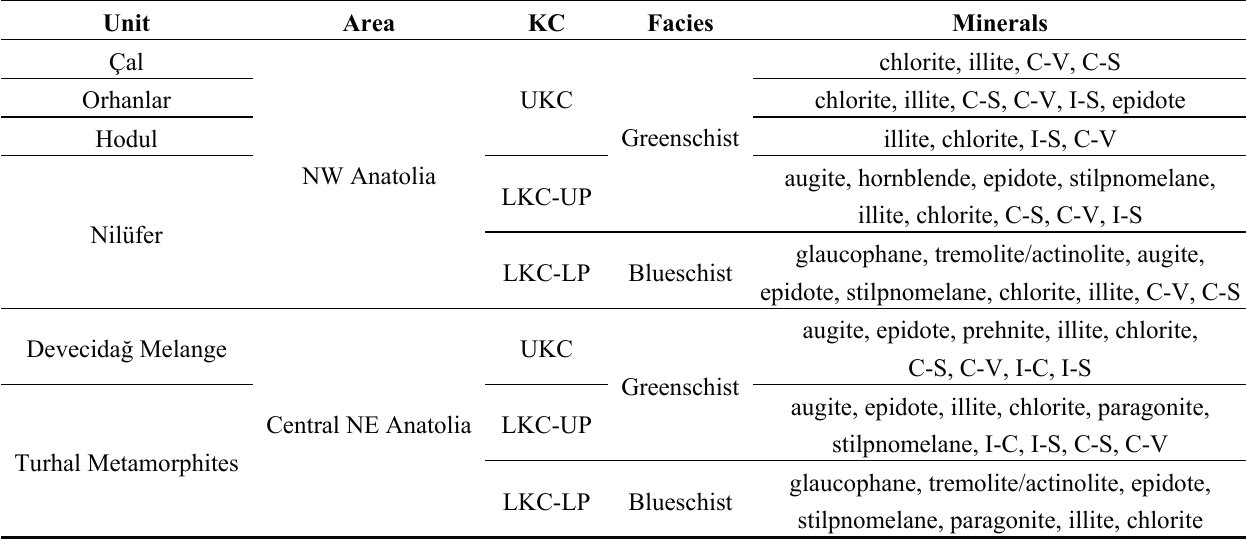
Figure 4. Scanning electron microscopy (SEM) photos of chlorite and associated minerals in the Lower Karakaya Complex units (Chl = Chlorite, I = Illite), ( a ) Platy chlorites in the shale sample of the Nilüfer Unit; ( b ) Thin-long filaments of illites in the shale sample of the Nilüfer Unit; ( c ) Radial needle-like chlorites and surrounding illites within the pores of metasandstones in the Turhal Metamorphites; ( d ) Fibrous illites in the metasandstones of the Turhal Metamorphites. Table 1. The dominant mineralogy of samples from the Karakaya Complex (KC) units.